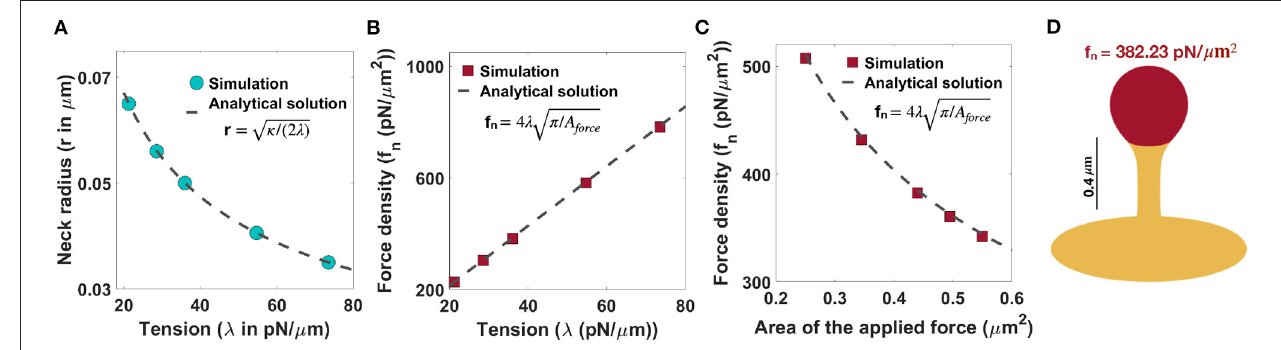
FIGURE 3 | Formation of thin-shaped spines with localized normal force density along the spine head. (A) Neck radius of a thin-shaped spine as a function of tension κ/ (2 λ )) (Derényi et al., 2002). (B) Linear relationship between the magnitude of normal force density needed to form a thin-shaped spine and the tension. Here, ( r = p the area of the applied force is set at A force 0.44 µ m 2 . The red squares represent the results obtained from simulation and the dashed line is the derived analytical = π/ A force , Equation (7)). (C) The magnitude of a normal force density needed to form a thin-shaped spine as a function of the area of the spine head. solution (f n 4 λ = p The tension is set at λ = 36 pN /µ m. The red squares represent the results obtained from our simulations and the dashed line is the derived analytical solution π/ A force ), Equation (7). (D) A thin-shaped spine with a total length L (f n 4 λ 0.98 µ m, neck radius r 0.05 µ m, and head volume V 0.033 µ m 3 is formed with = = = = p f n 382.23 pN /µ m 2 applied along the head of spine which is shown in red ( λ = 36 pN /µ m and A force 0.44 µ m 2 ). = =